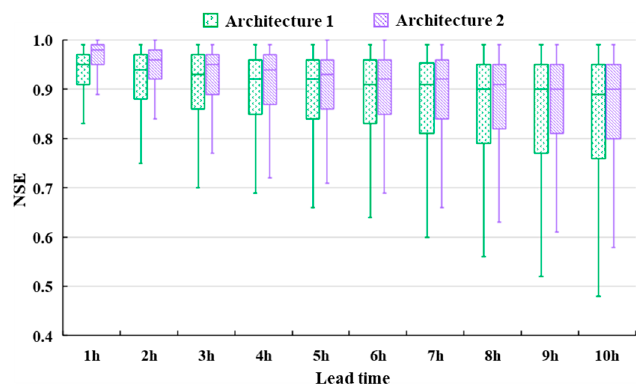
Figure 14. NSE for different model architectures at 1–10 ‐ h lead ‐ time.